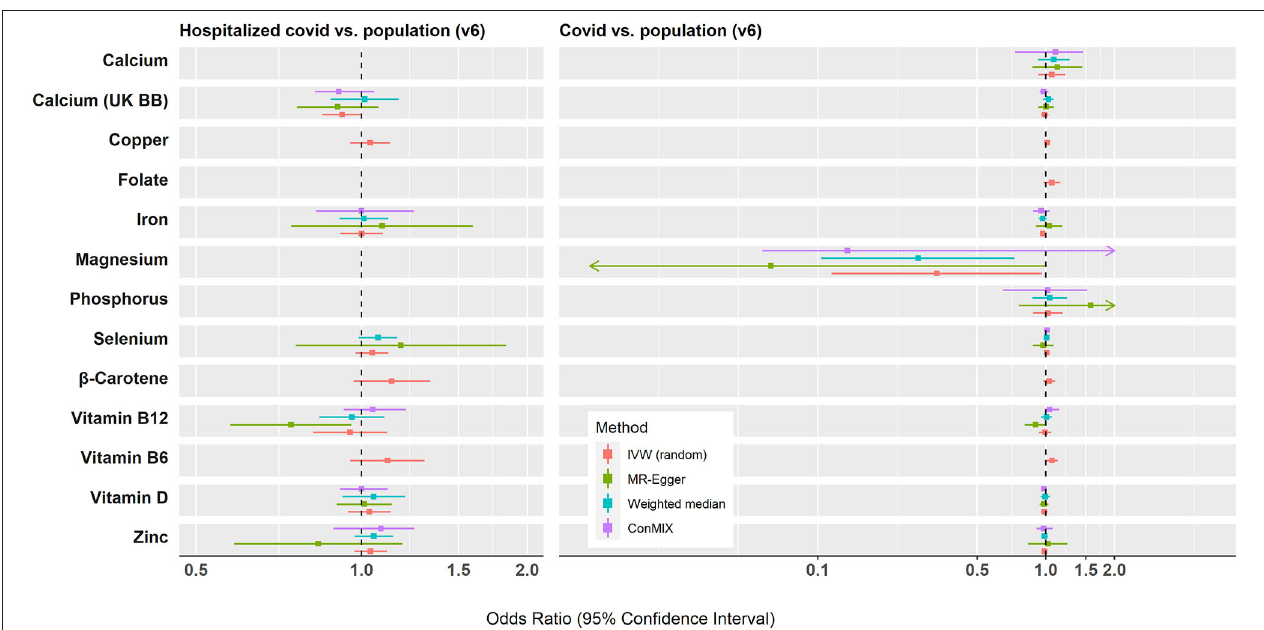
FIGURE 2 | Summary of the Mendelian randomization results for the associations between genetically predicted micronutrient concentrations and COVID-19 outcomes. IVW, inverse variance weighted; conMIX, contamination